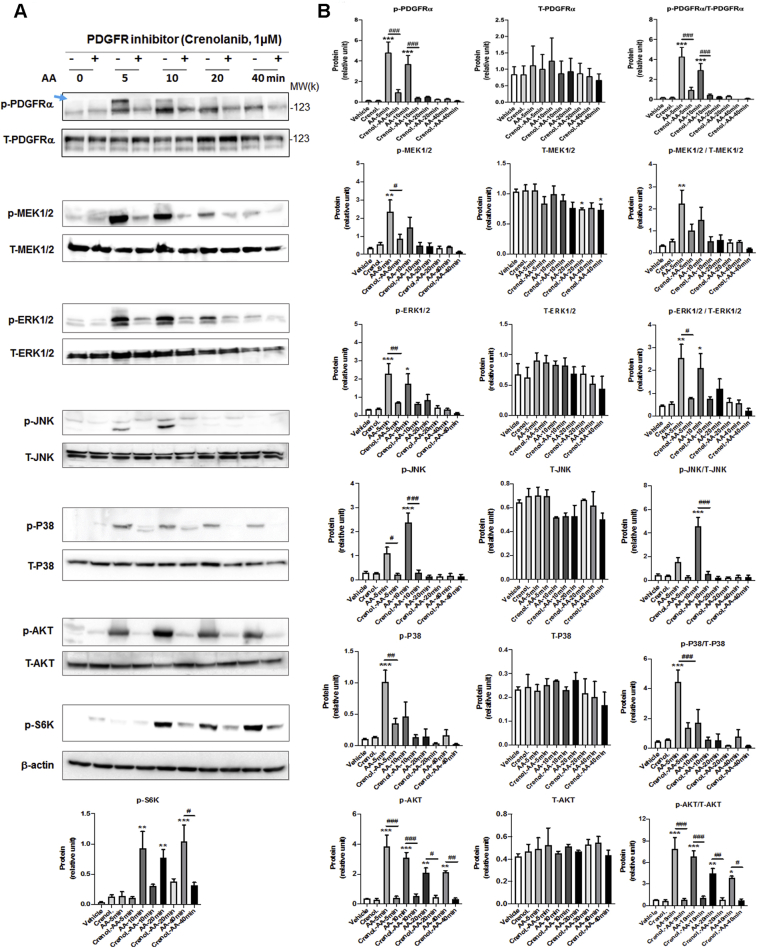
PDGFR Inhibition Blocks the Phosphorylation of Downstream KinasesRat primary adventitial fibroblasts were cultured, starved, and pretreated with vehicle (DMSO) or PDGFR-selective inhibitor crenolanib (1 μmol/l, 30 min). The arrow points to the bands of phospho-PDGFRα that were sensitive to both AA stimulation and inhibitor pretreatment. (A) Representative Western blots showing blockade of AA-induced kinase activation by the PDGFR-selective inhibitor crenolanib. p- = phospho-protein; T- = total protein. (B) Quantification: mean ± SEM, n ≥3 experiments. One-way ANOVA/Bonferroni test: #p < 0.05; ##p < 0.01; ###p < 0.001. ∗p < 0.05; ∗∗p < 0.01; ∗∗∗p < 0.001 compared with the vehicle control without AA stimulation (the first bar in each plot). Abbreviations as in Figures 1 and 4.